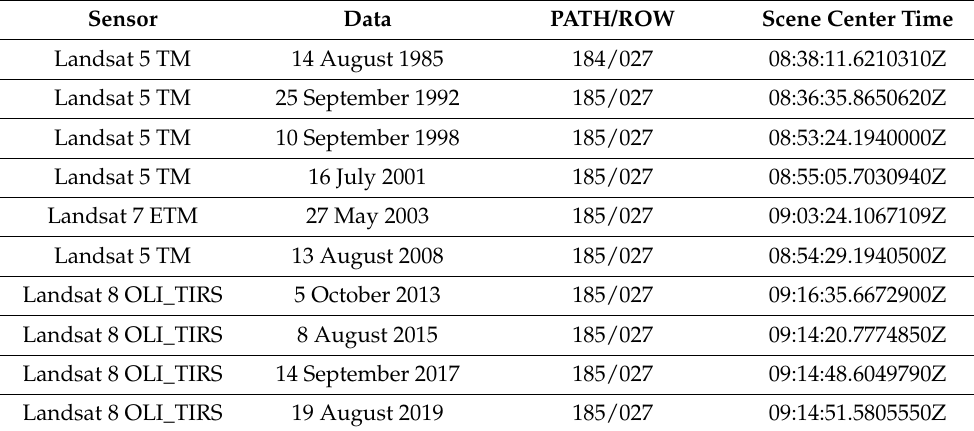
Table 1. Specification of Landsat data used in study.